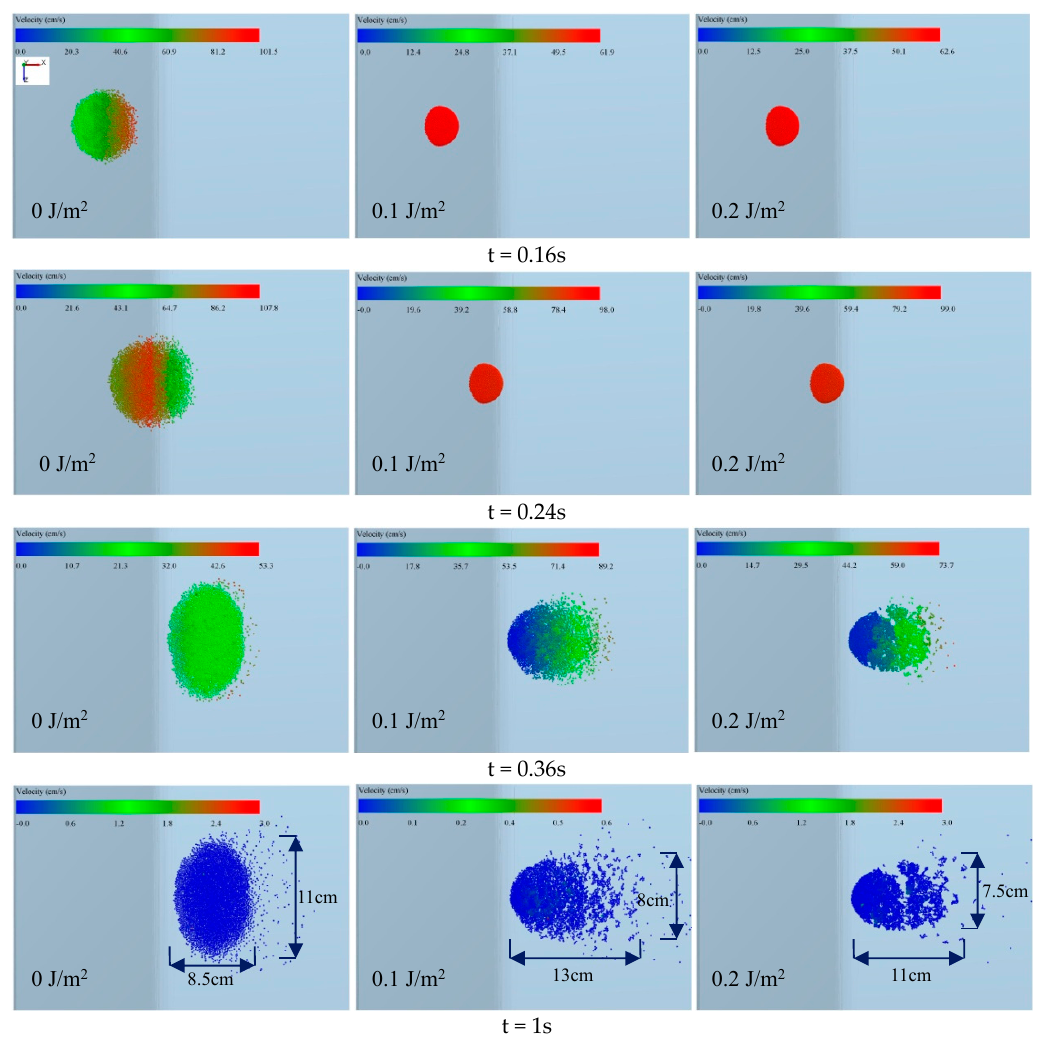
Water 2019 , 11 , x FOR PEER REVIEW Figure 16. Diagrams the sliding process of wet soil granular flow. Figure 16. Diagrams the sliding process of wet soil granular flow.